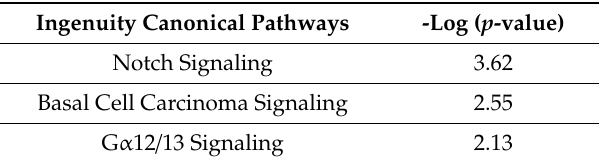
Table 2. Pathways activated in the first metastatic relapse. The -log of p -value (calculated by Fisher’s exact test right-tailed) is indicated. Only pathways with a -log of p -value of more than 2 are shown.